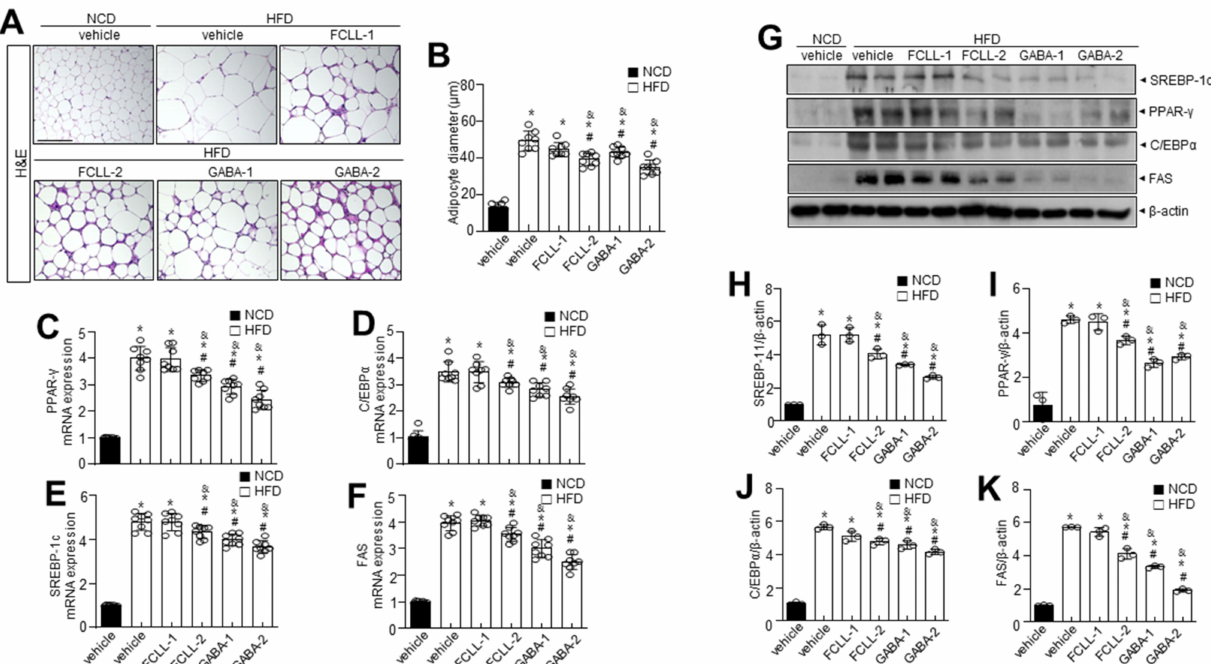
Figure 4. GABA and fermented Curcuma longa L. extract enriched with GABA determine adipose tissue expansion and adipogenic factors in eWAT. Mice were fed with NCD or HFD with vehicle or GABA and GABA-enriched Curcuma longa L. extract (1 or 2 g/kg) once daily for 14 weeks by oral gavage. ( A ) H&E staining in eWAT. Scale bar = 50 µ m. ( B ) The average diameter of adipocytes